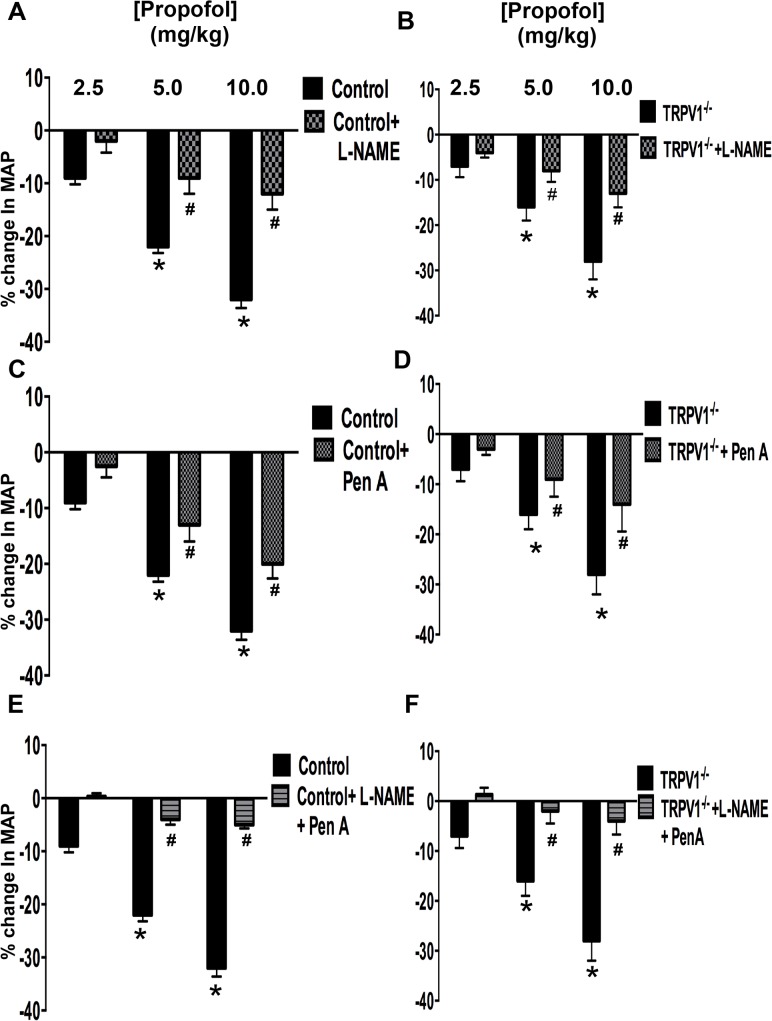
Propofol induced changes in MAP in Control and TRPV1-/- mice: Panels A and B: Summarized data depicting the effect of L-NAME (100 mg/kg/min) on propofol-induced changes in MAP in control and TRPV1-/- mice.Panels C and D: Summarized data depicting the effect of Pen A (50 ug/kg/min) on propofol-induced changes in MAP in control and TRPV1-/- mice. Panels E and F: Summarized data depicting the effect of L-NAME and Pen A in combination on propofol-induced changes in MAP in control and TRPV1-/- mice. Data are means ± SEM. *P<0.05 compared to baseline. #P<0.05 compared to control. n = 6 mice in each group.